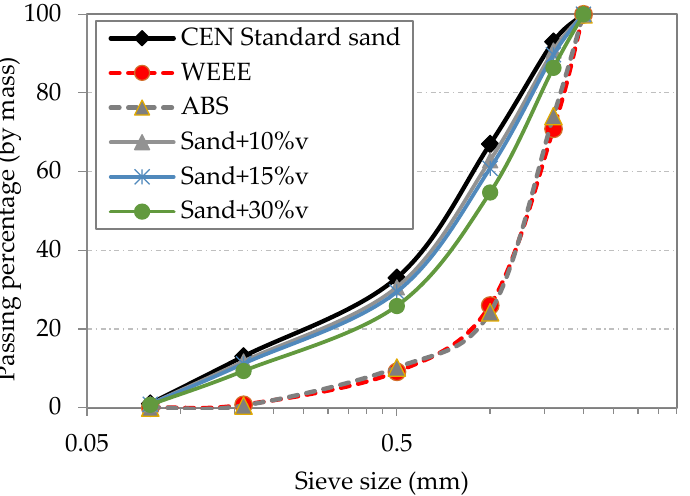
Figure 2. Particle size distribution of standard sand and plastic aggregates. Table 1. Absolute density of materials.